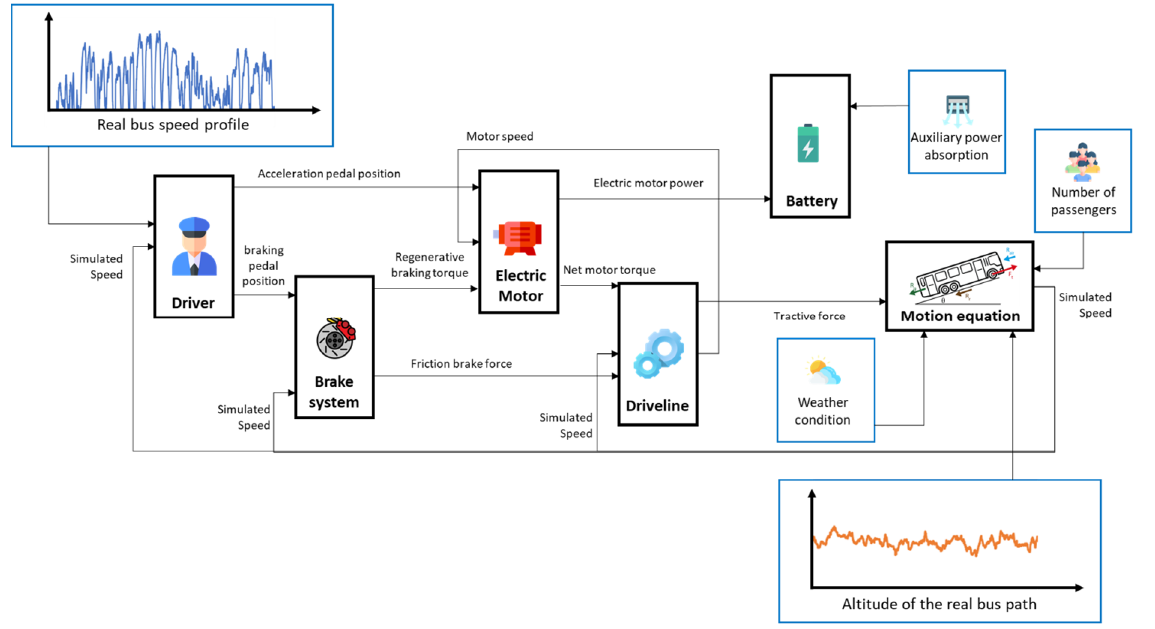
Figure 3. Simulink model information diagram.